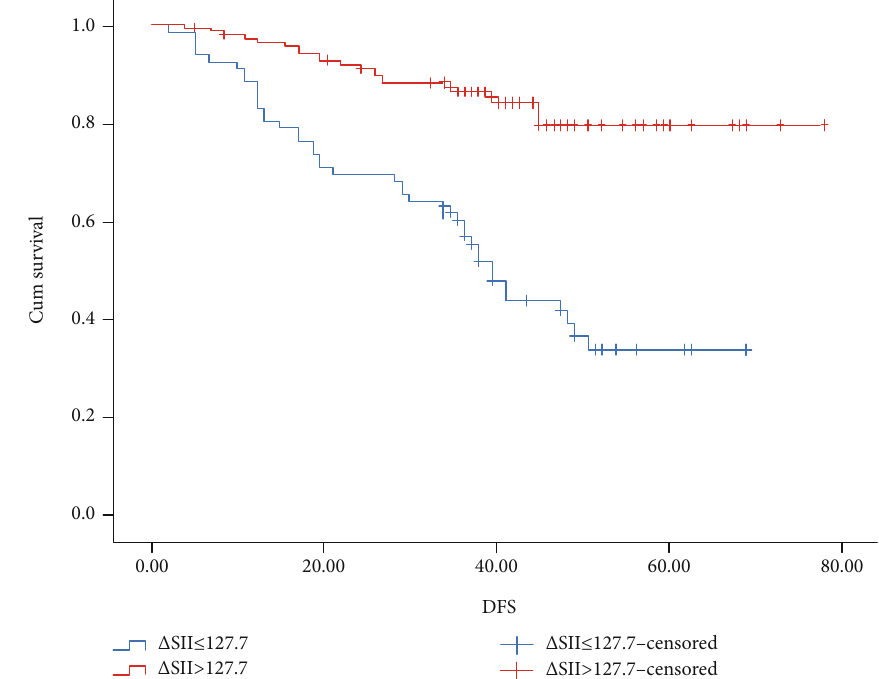
Figure 3: Kaplan-Meier graphs of disease-free survival for patients in the high- Δ SII group ( > 127.7) and low- Δ SII group ( ≤